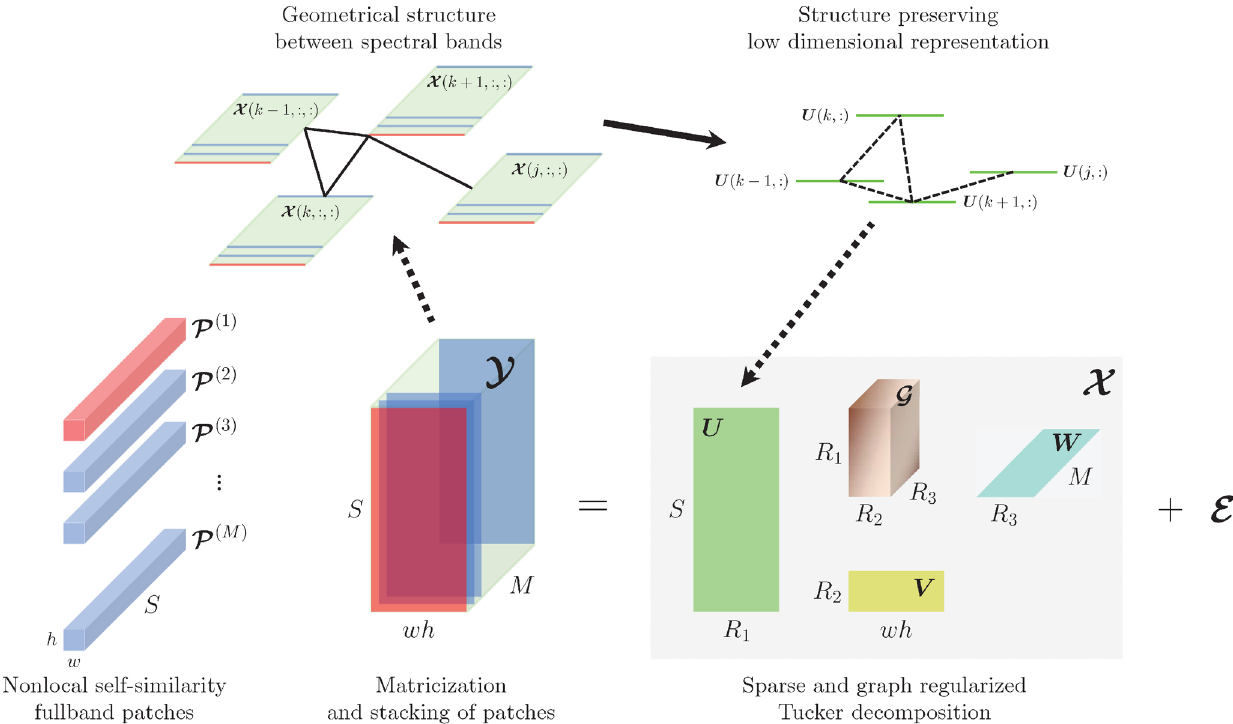
Fig. 1 Concept of our method. Superscripts i in full-band patches, and ( i ) in patch tensors are omitted for simplicity. We investigate the priors of non-local self-similarity and spectral correlation based on a patch framework. Non-local similar full-band patches P (2) , ··· , P ( M ) are extracted for a selected full-band patch P (1) , and a noisy patch tensor Y delivering the two priors is built by matricizing and stacking those patches. We use Tucker decomposition to capture the correlation simultaneously in all different directions. In this representation, the patch tensor X of a clean MSI has the properties of multilinear low-rank and a sparse core tensor. Furthermore, the local geometrical structure linking spectral bands is also considered. We use a weighted graph, reconstructed using the noisy patch tensor Y or spectral priors, to characterize the intrinsic local structure. Graph embedding is utilized to jointly learn a sparse low-rank representation while preserving the graph